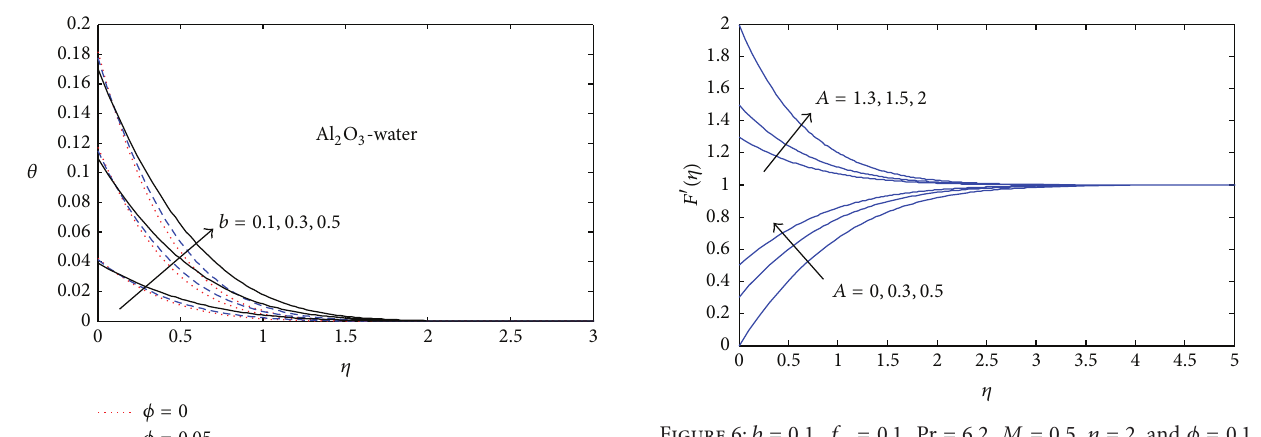
Figure 6: 𝑏 = 0.1 , 𝑓 𝑤 = 0.1 , Pr = 6.2 , 𝑀 = 0.5 , 𝑛 = 2 , and 𝜙 = 0.1 .